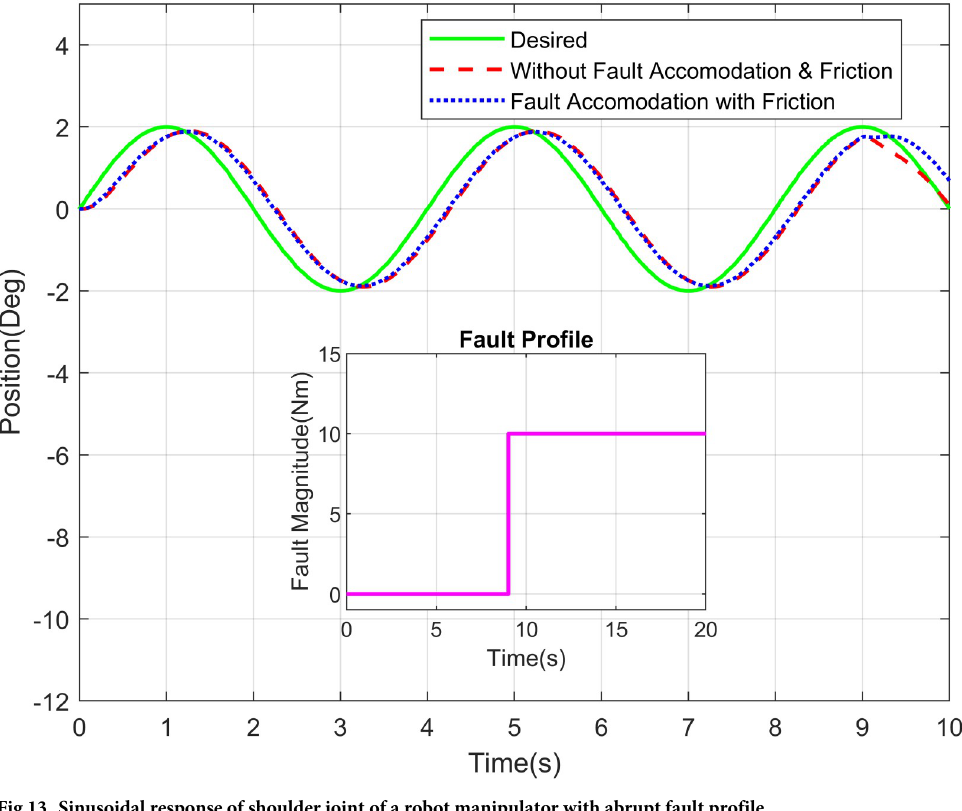
Fig 13. Sinusoidal response of shoulder joint of a robot manipulator with abrupt fault profile.